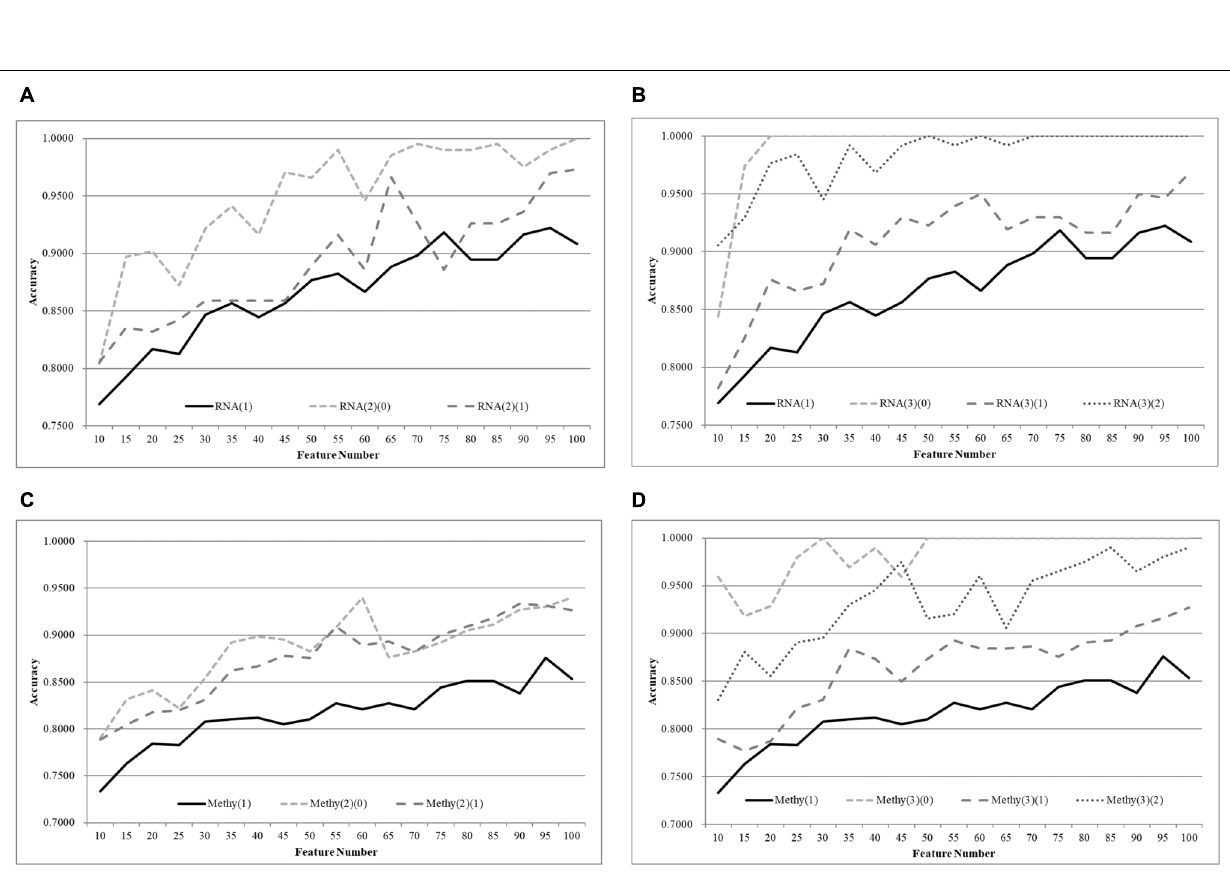
Frontiers in Genetics |